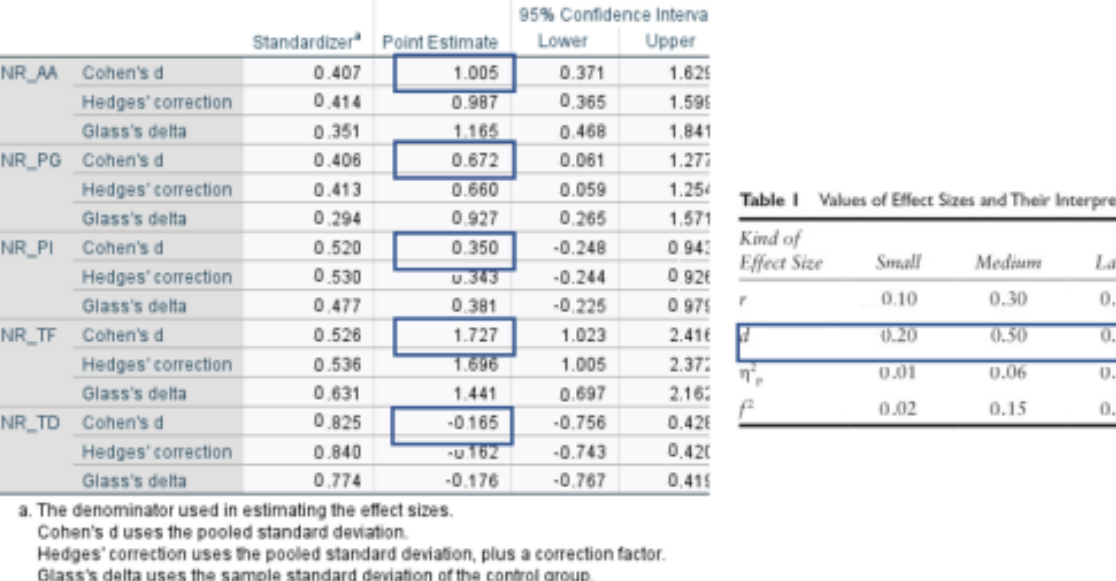
Figure 1. Differences: effect size based on differences between groups (e.g., Cohen’s d, Glass’ Δ , Hedges’ g, Odds ratio, and Relative risk) [23]. Hedges’ g, Odds ratio, and Relative risk)